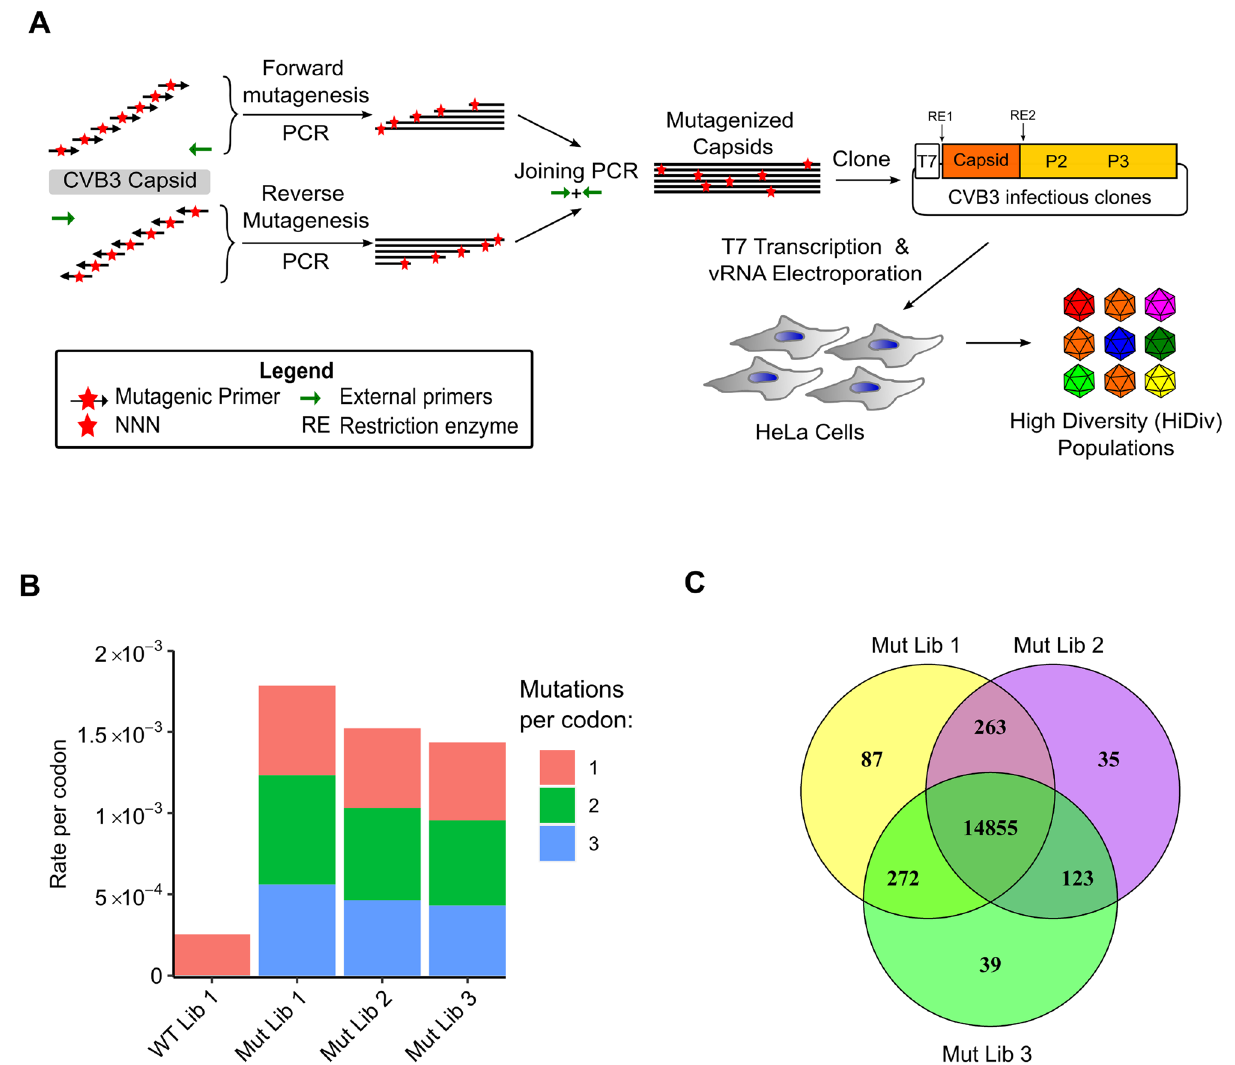
Figure 1. Codon-level mutagenesis of the CVB3 capsid. ( A ) Schematic representation of the mutagenesis protocol. A forward mutagenesis PCR reaction was performed using a single external reverse primer and a pool of forward mutagenic primers targeting each codon in the capsid, each primer encoding degenerate nucleotides (NNN) at the codon matching position. Similarly, a reverse mutagenesis PCR reaction was performed using a mix of reverse mutagenic primers targeting all codon sites in the capsid and a single external forward primer. The product of these PCRs was joined using the external primers and cloned into the CVB3 infectious clone to generate the mutagenized libraries. Viral genomic RNA (vRNA) was produced via in vitro transcription and electroporated into cells to generate high diversity CVB3 populations (HiDiv). ( B ) The mutation rates for single, double, and triple mutations within codons observed in the control, unmutagenized library (WT Lib 1) or the mutagenized libraries (Mut Lib 1–3). ( C ) Venn diagram showing the number of amino acid mutations observed in the mutagenized